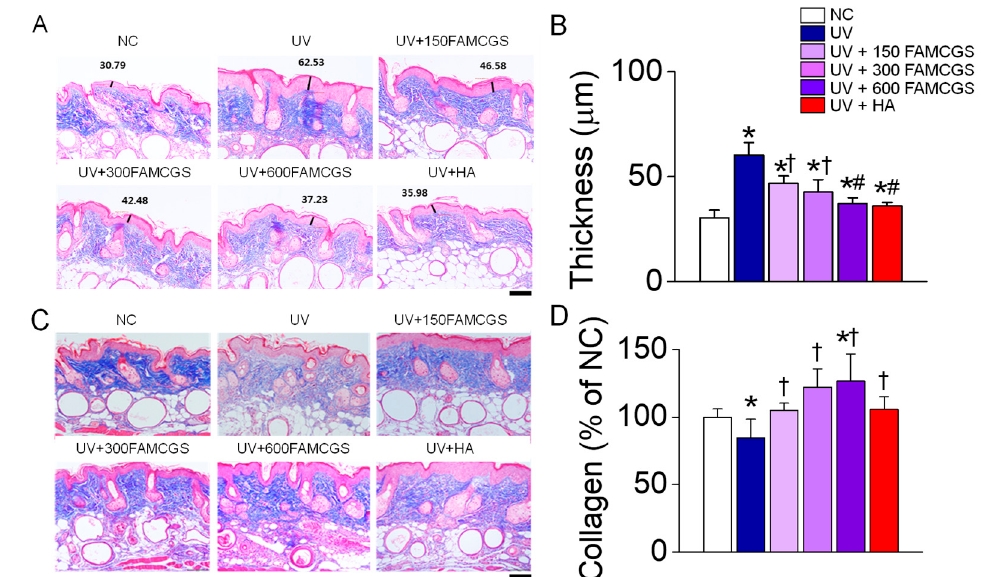
Figure 4. Effect of FAMCGSs on UV-induced skin histological changes. Epidermal thickness and dermal collagen density were assessed by Masson’s trichrome staining. ( A , B ) Changes in epidermal thickness. ( C , D ) Changes in dermal collagen density. Scale bar, 100 µm. Each bar represents the mean ± SD ( n = 5 in each group). * p < 0.05 compared to the NC group. † p < 0.05 compared to the UV group. # p < 0.05 compared to the UV + 150 FAMCGS group.